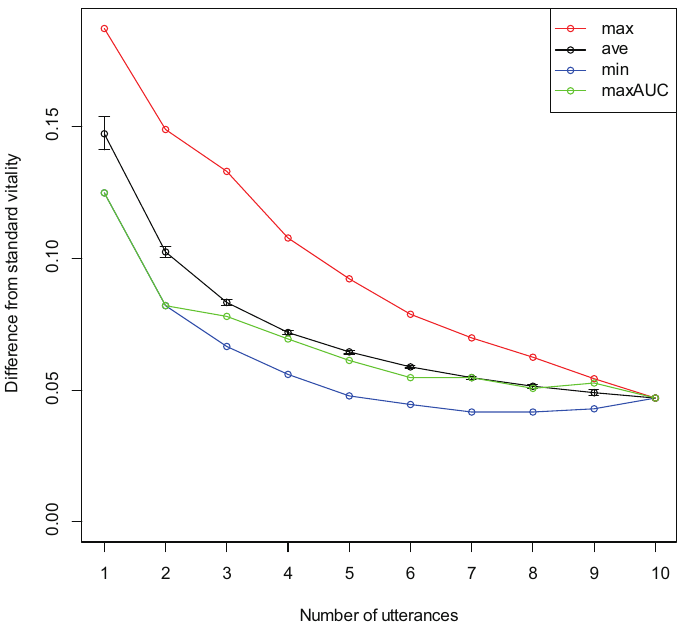
Figure 6. Difference from standard vitality for each number of